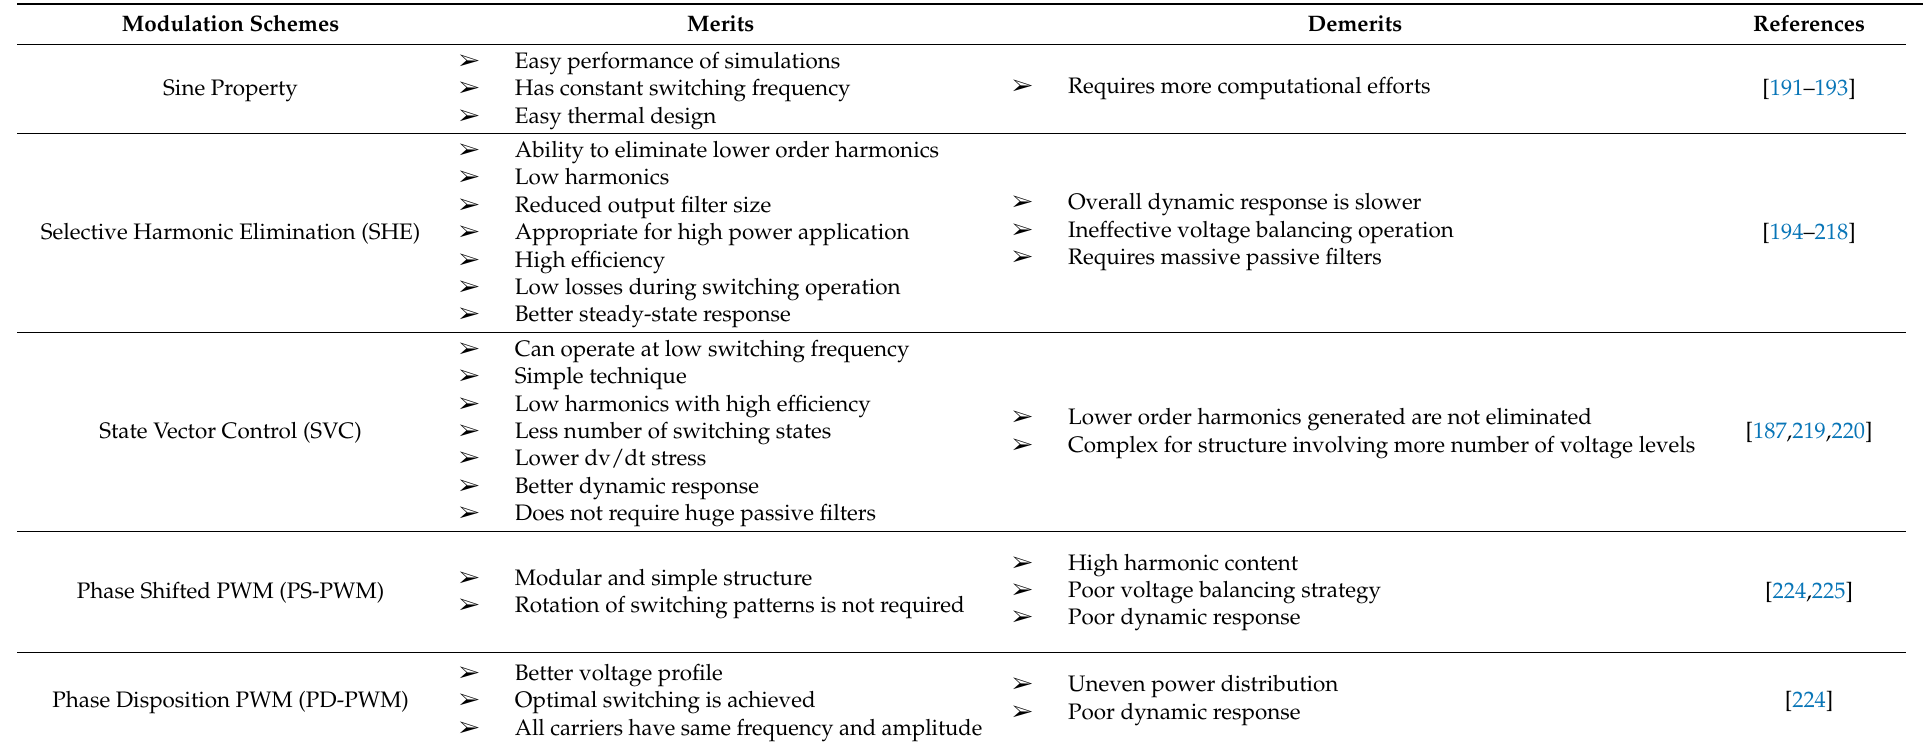
Table 3. Comparative study highlighting the merits and demerits of basic modulation